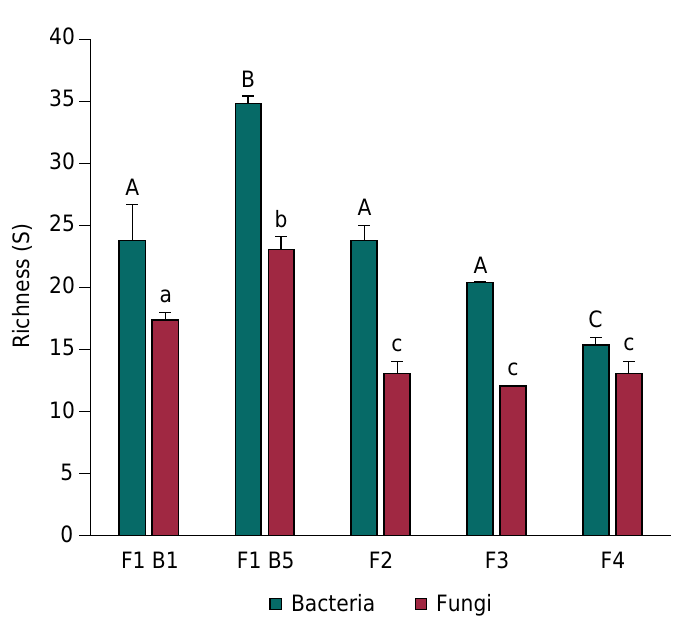
Figure 2. Diversity of fungal and bacterial communities as evaluated by richness (S). The diversity value presented in the graph is the average calculated from the three composite samples collected at each sampling site. Different uppercase letters indicate a significant difference among bacterial communities at p<0.05. Different lowercase letters indicate a significant difference among fungal communities at p<0.05. Both analyses are according to the Tukey test. Sites under EM: F1B1 = block 1 in Farm 1 and F1B5 = Block 5 in Farm 1; sites under IM: F2 = Farm 2 and F3 = Farm 3; and site under CM: F4 = Farm